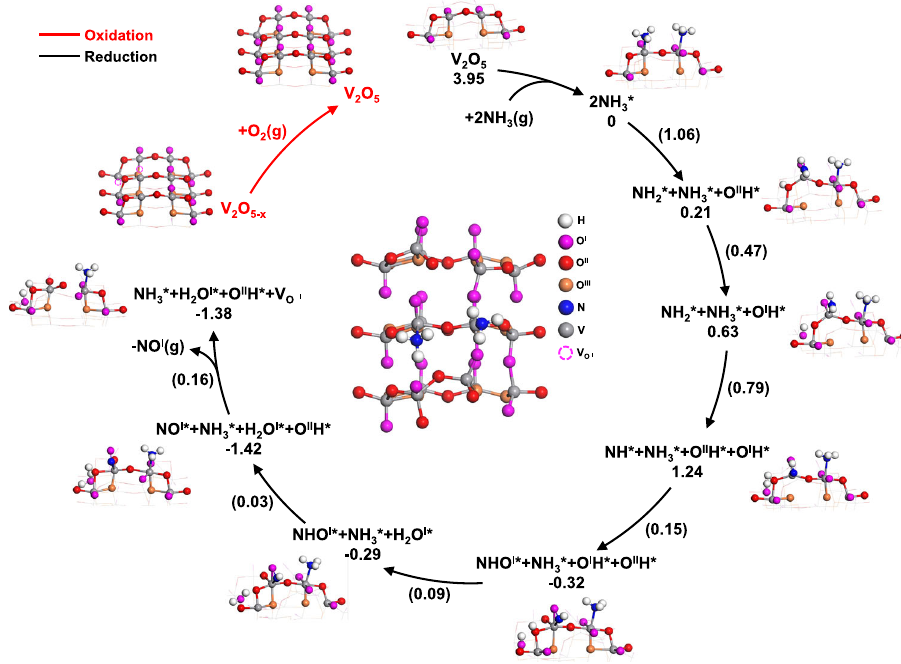
Fig. 7 Proposed reaction mechanism. Schematic of the proposed reaction mechanism for CLAO process over V 2 O 5 redox catalyst. The elementary reaction barriers are given in